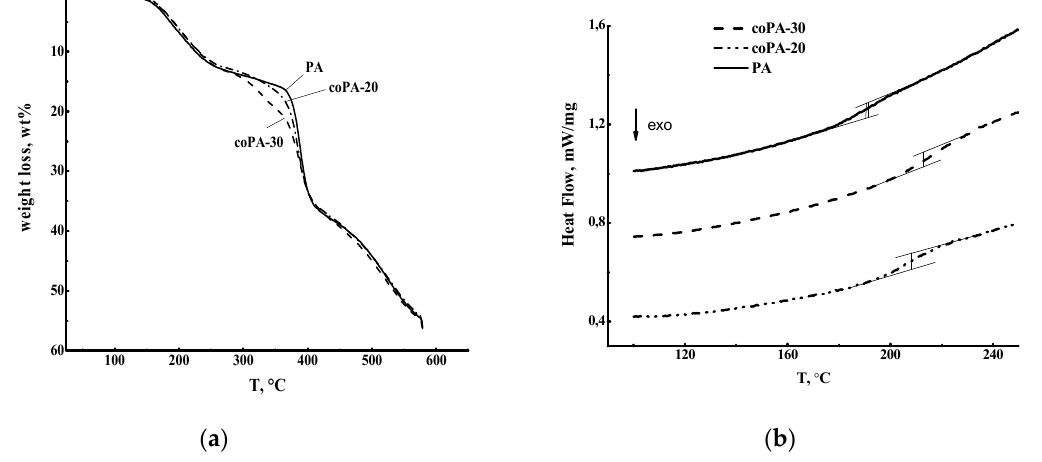
Figure 2. ( a ) Thermogravimetric (TG) and ( b ) differential scanning calorimetry (DSC) curves of PA, coPA-20, and coPA-30.